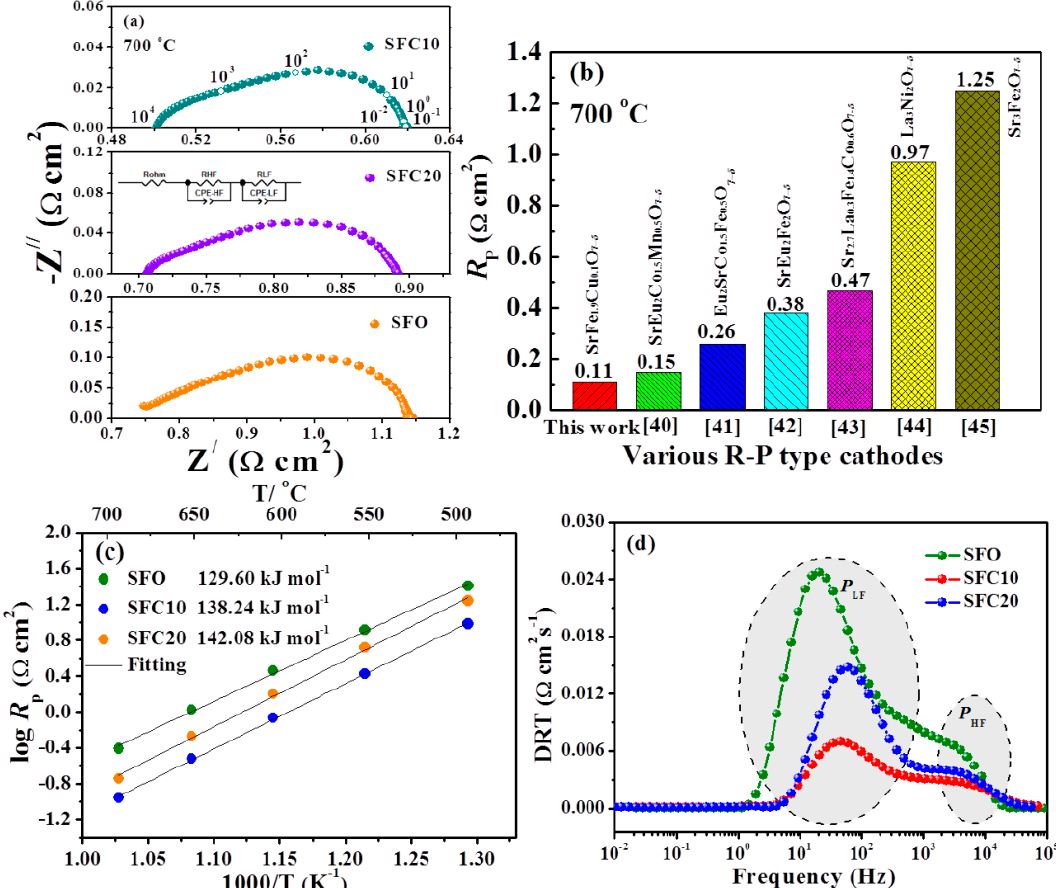
Figure 6. ( a ) EIS patterns of SFC x cathode collected at 700 ◦ C in air; ( b ) R p value of various Ruddlesden − Popper-type cathode materials at 700 ◦ C; ( c ) Arrhenius curves of polarization resistance for SFC x cathode materials at 500–700 ◦ C; ( d ) DRT analysis of the impedance spectra for SFC x electrodes at 700 ◦ C.